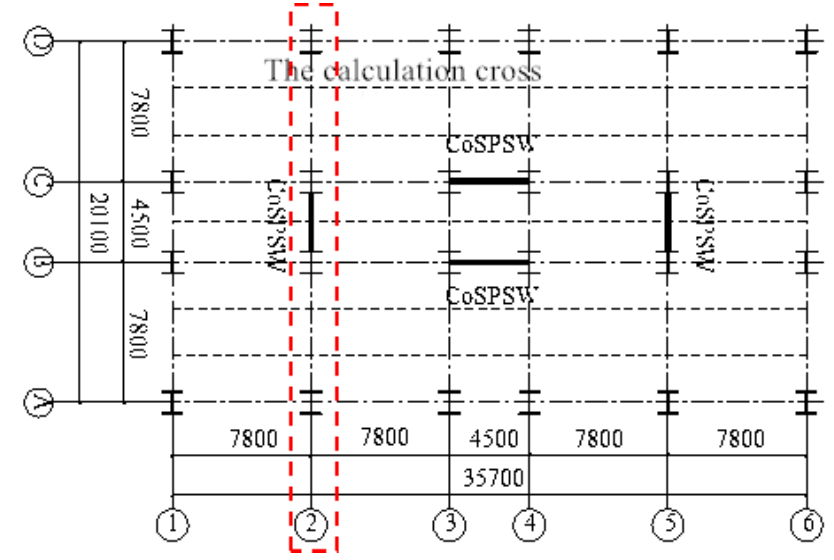
Figure 3. Floor Plan of the Structure.